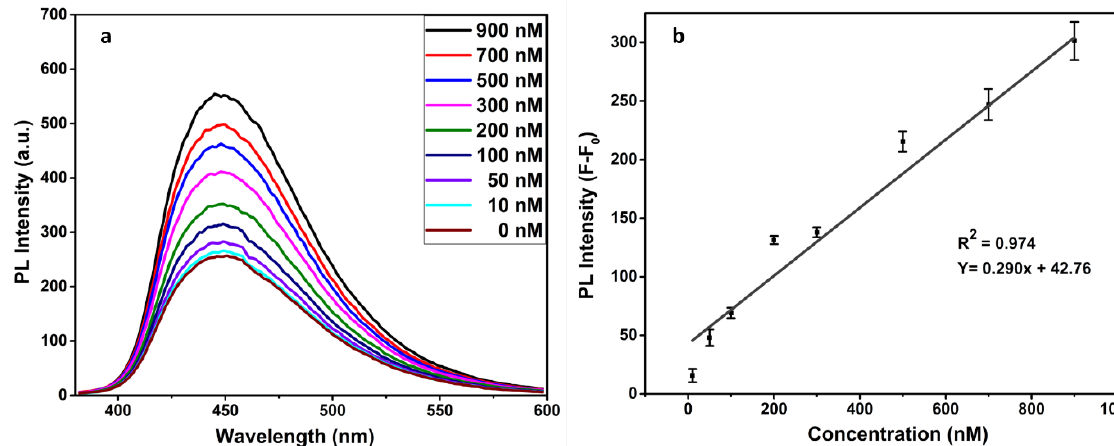
Figure 7. Change in PL intensity with different concentrations of progesterone hormone ( a ) and representative of a linear regression ( b ).